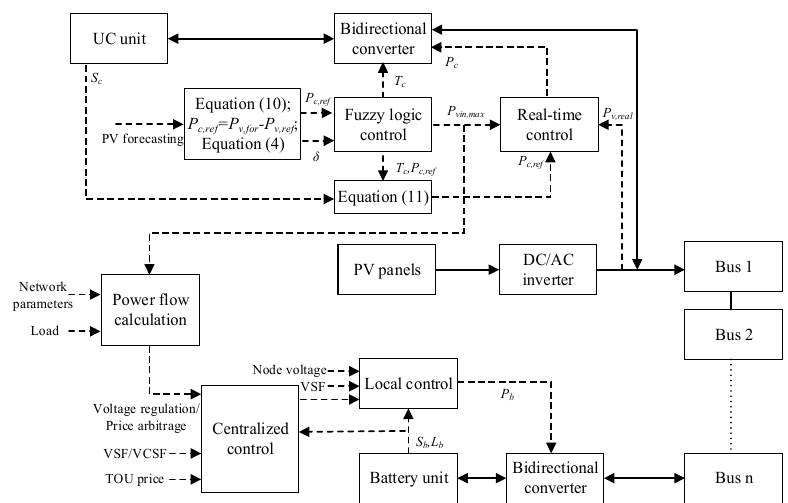
Figure 2. Structure of the hierarchical operation strategy.